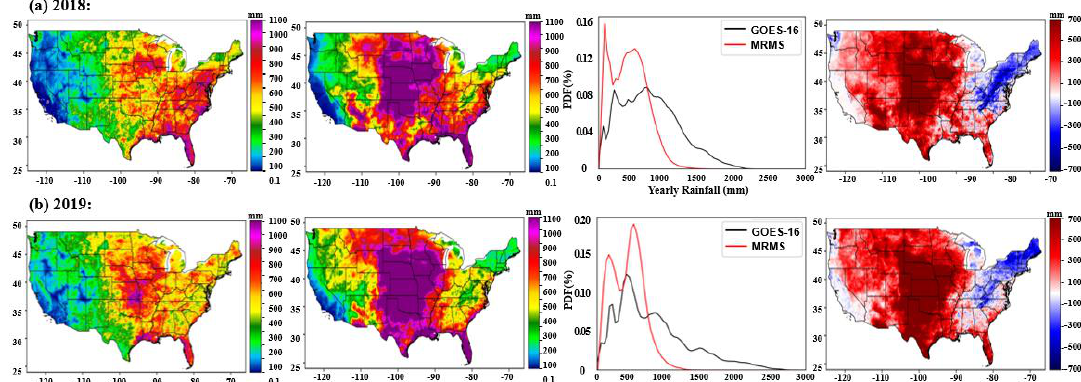
Figure 4. Total rainfall accumulations during the warm season (May to September) in ( a ) 2018 and ( b ) 2019. From left to right, the columns are: GC-MRMS, GOES-16 QPE, PDF of seasonal precipitation accumulations, and the difference between GOES-16 QPE and GC-MRMS (the former minus the latter).